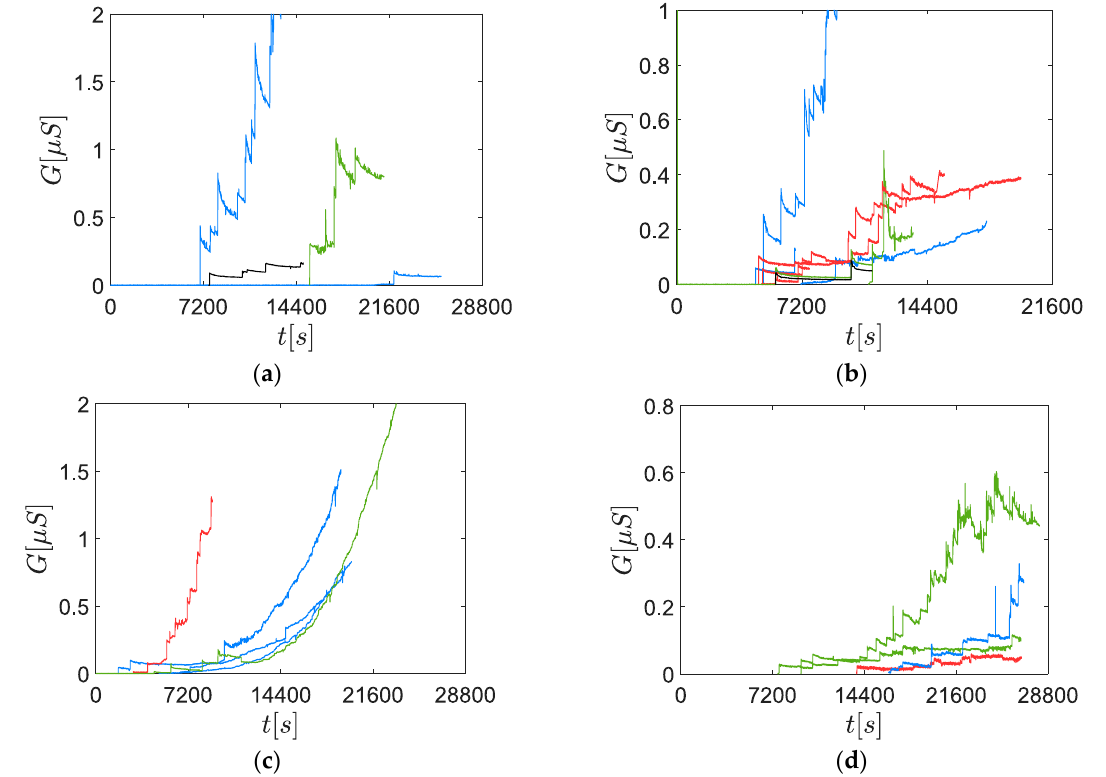
Figure 7. Sample of the soot sensor responses to a DMA-classified aerosol for different mobility diameters and different polarization tensions (red: 30 V; blue: 50 V; green: 70 V; black: 100 V). ( a ) d m = 60 nm; ( b ) d m = 70 nm; ( c ) d m = 80 nm; ( d ) d m = 100 nm .